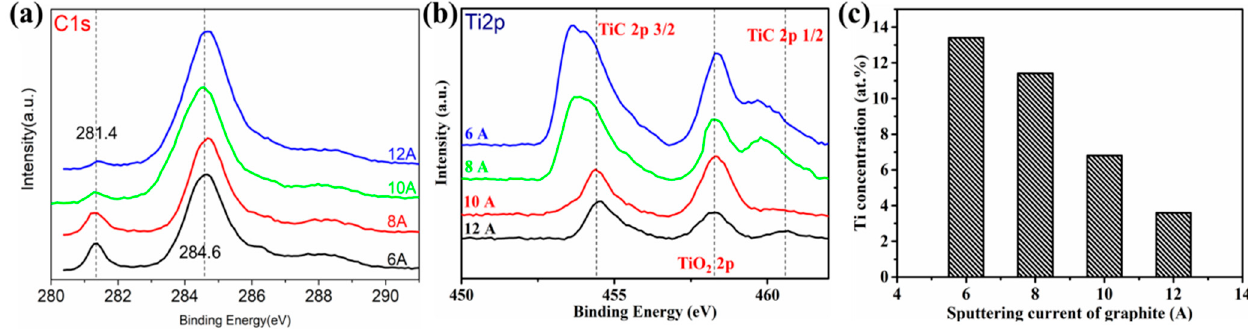
Figure 1. XPS characterizations ( a ) C1s peaks, ( b ) Ti 2p peaks and ( c ) Ti content of the films deposited at various sputtering currents of graphite.